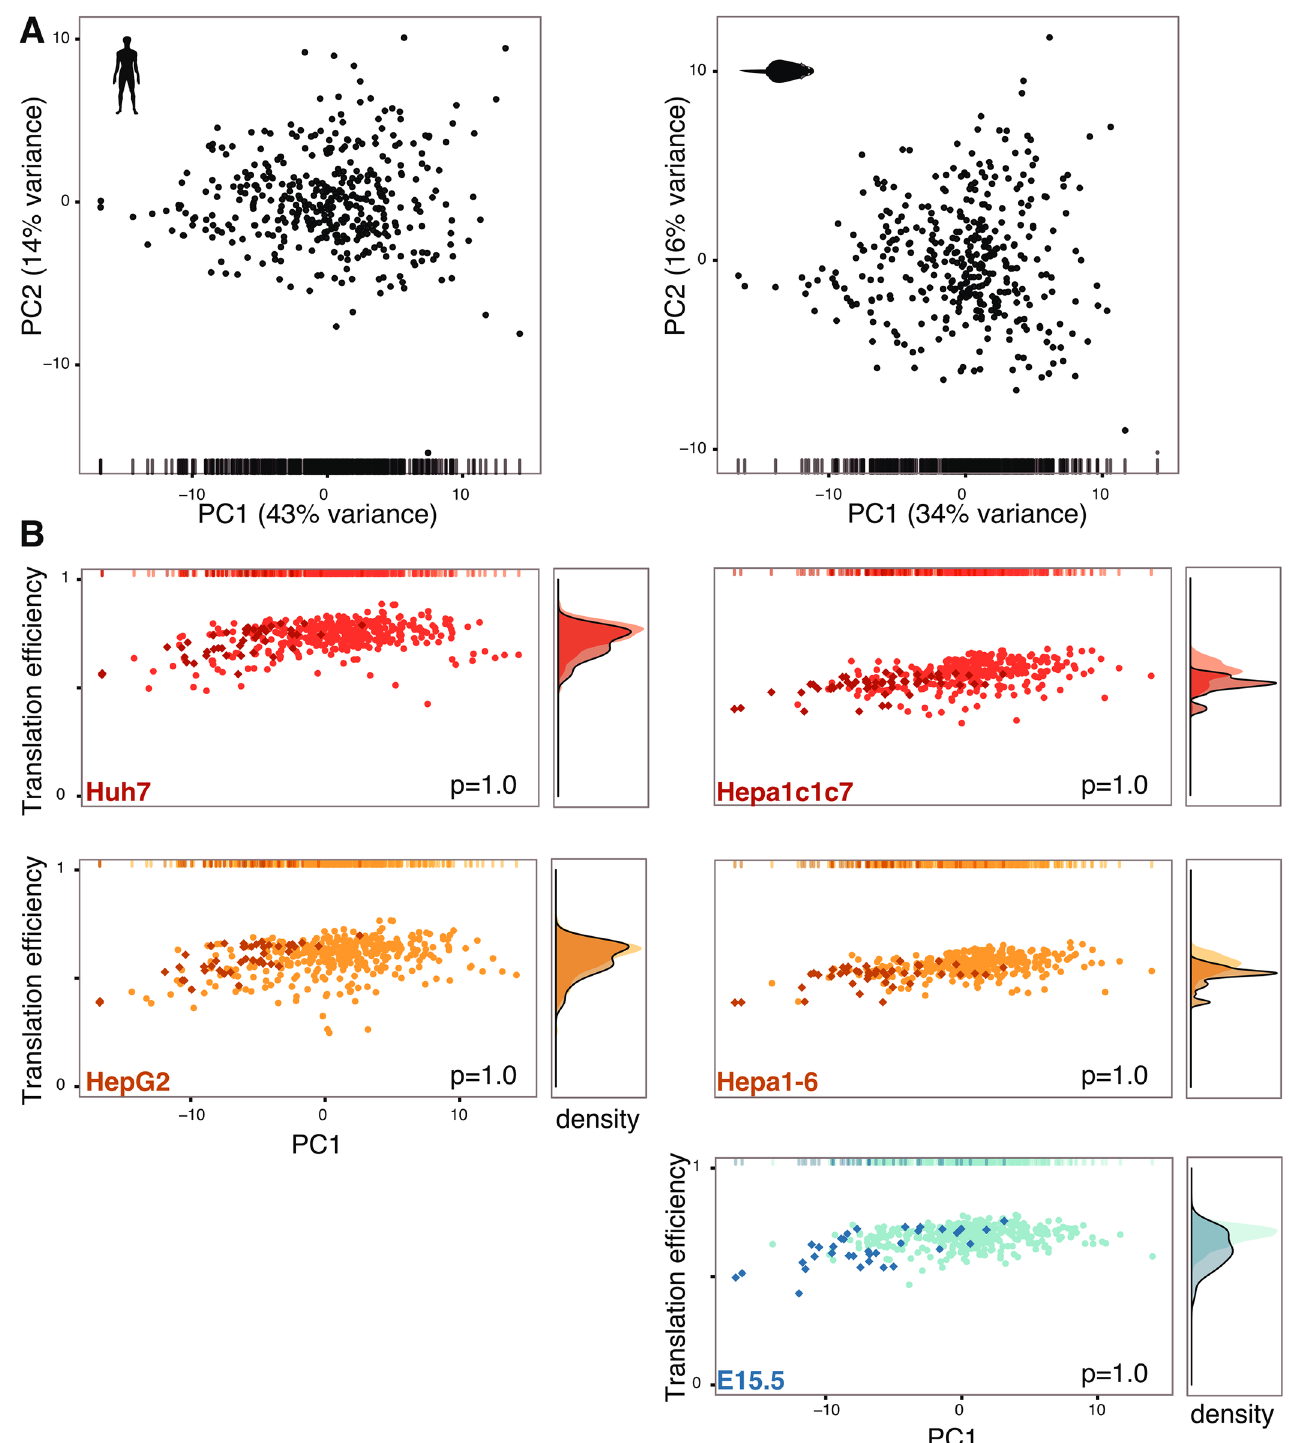
Fig 4. Translational efficiency does not correlate with cell-type-specific codon usage. ( A ) Factorial map of the principal components (PC) analysis of genomic codon usage per Gene Ontology (GO) term in adult liver (left: human; right: mouse). Each point corresponds to one GO term. The position of each point is given by the first (x-axis) and second (y-axis) principal component of the corresponding GO term ’ s codon usage. The proportion of variance explained by each PC is shown in parentheses. The bar at the bottom corresponds to the x-coordinate of each GO term. ( B ) Cell type-specific translational efficiency of each GO term is plotted against their first principal component shown in ( A ) (indicated by bar at top;